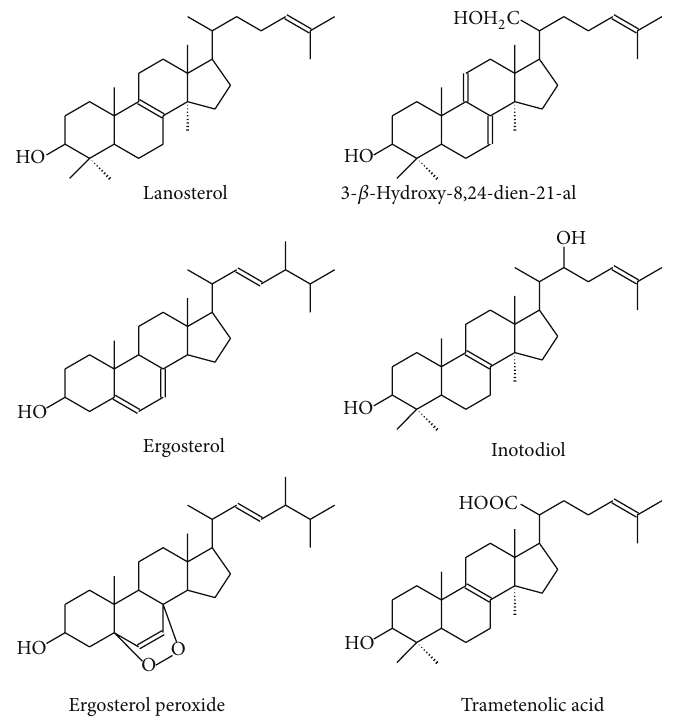
Figure 4: Structures of different sterol compounds isolated from I. obliquus